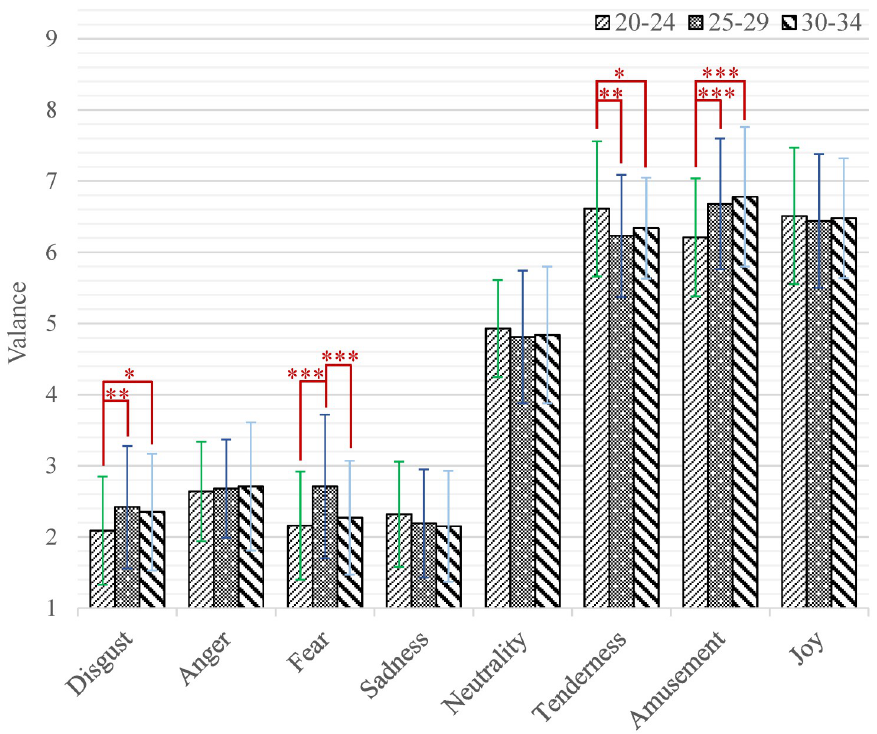
Fig 1. The valence scores of each category of emotion-inducing short videos among participants with different ages. Statistical significance: * p < 0.05, ** p < 0.01, *** p < 0.001. Unless marked with the asterisk, no significant differences between these groups were